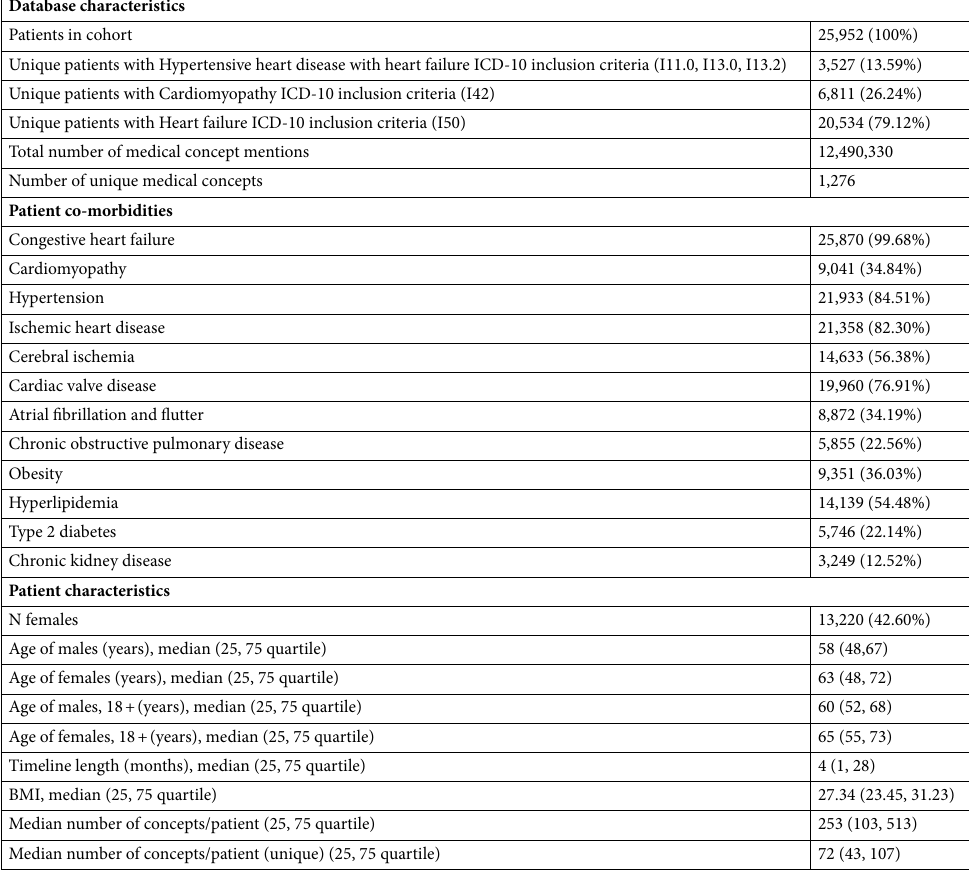
Table 1. Baseline characteristics of the heart failure